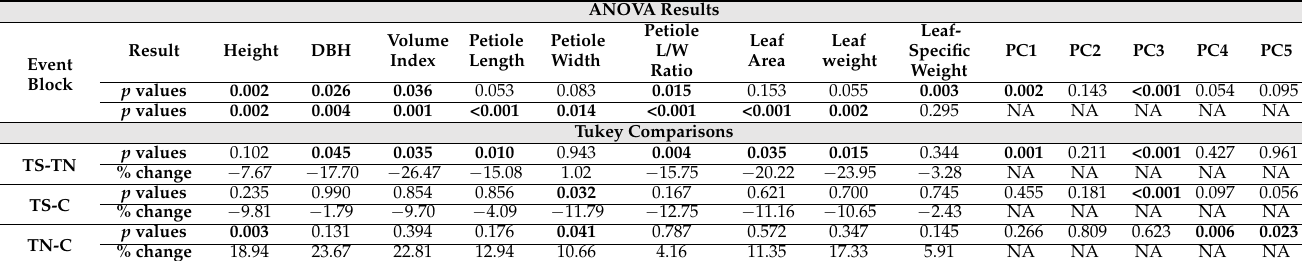
Table 1. Summary of p -values from ANOVA tests and Tukey comparisons. Comparisons between groups are shown with a-sign, such as TS-TN. Significant values ( p < 0.05) are shown in bold; NA is non-applicable.